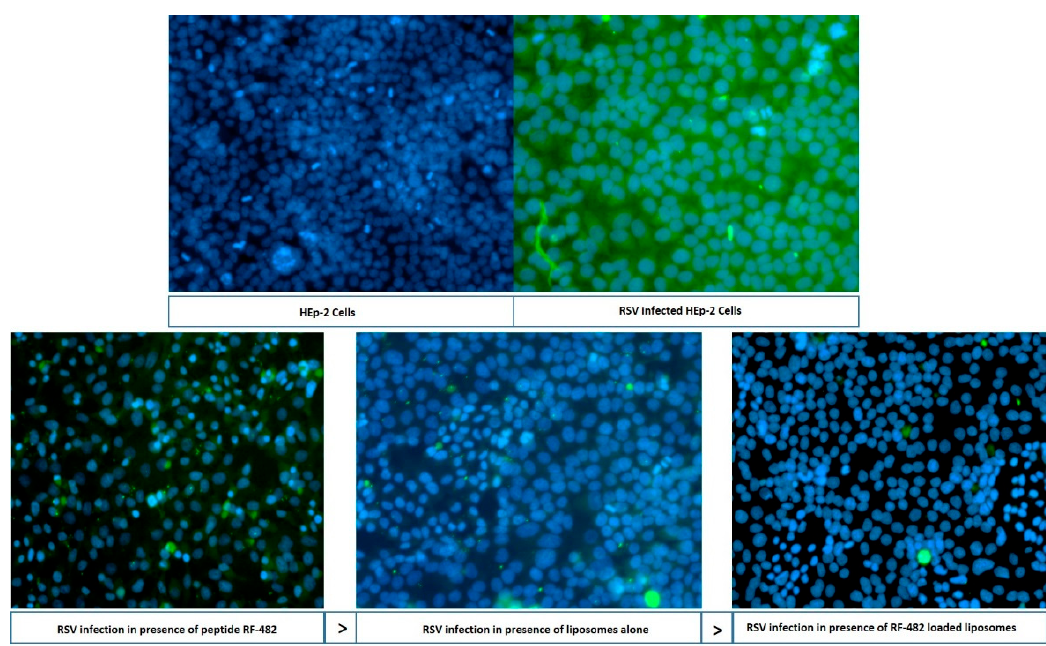
Figure 6. Fluorescence microscopy analysis. FITC (green)—RSV; and DAPI (blue)—HEP-2 cell nucleus. In liposomes and RF-482 liposomes, the blue color represents the survived cells, and the green color represents the presence of RSV.